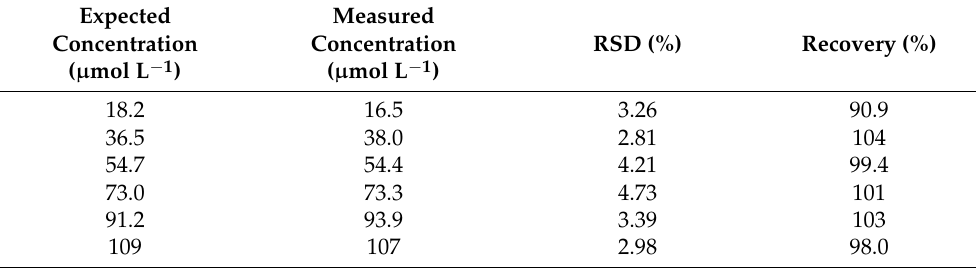
Table 2. Study of method repeatability and recovery.